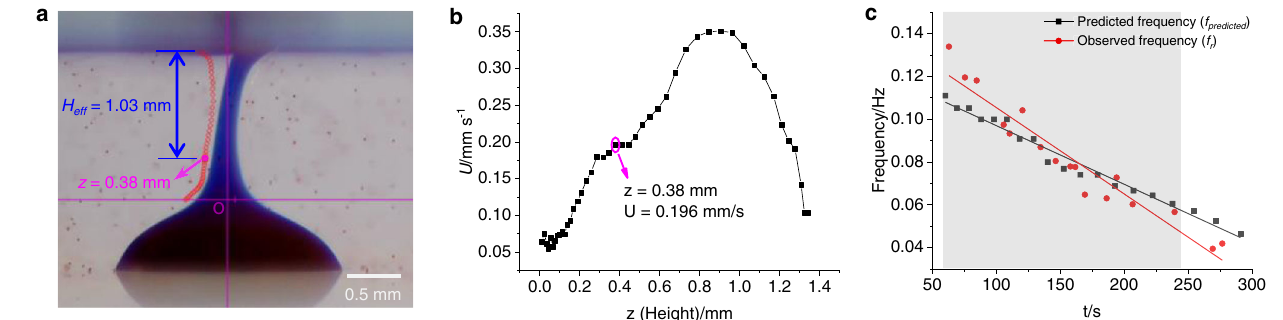
Fig.8 |Calculationofthecoilingfrequency.a ThetrajectoryofaPSparticle near the fi lament moving up from the droplet to the surface of the bulk solution (102.8 to109.8sinSupplementaryMovie5). b Depth-dependentverticalvelocity U ( z )ofa PS particle nearthe fi lament moving up from the dropletto the surface of the bulk